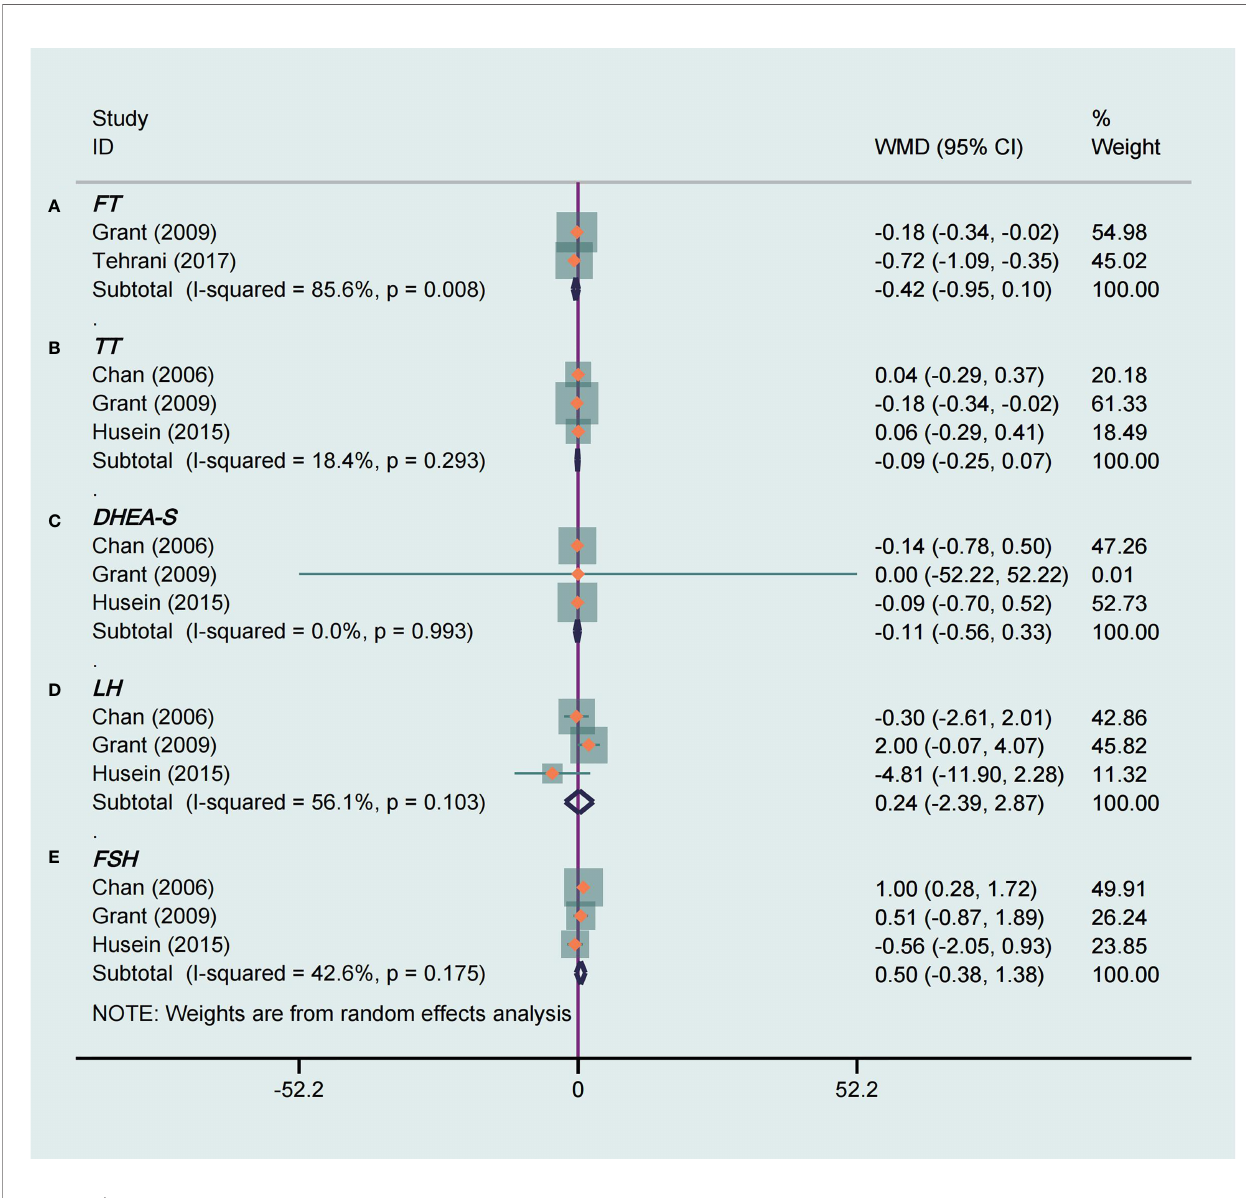
FIGURE 5 | Meta-analyses of the effect of tea supplements on hormone parameters. (A) FT, (B) TT, (C) DHEA-S, (D) LH, and (E)